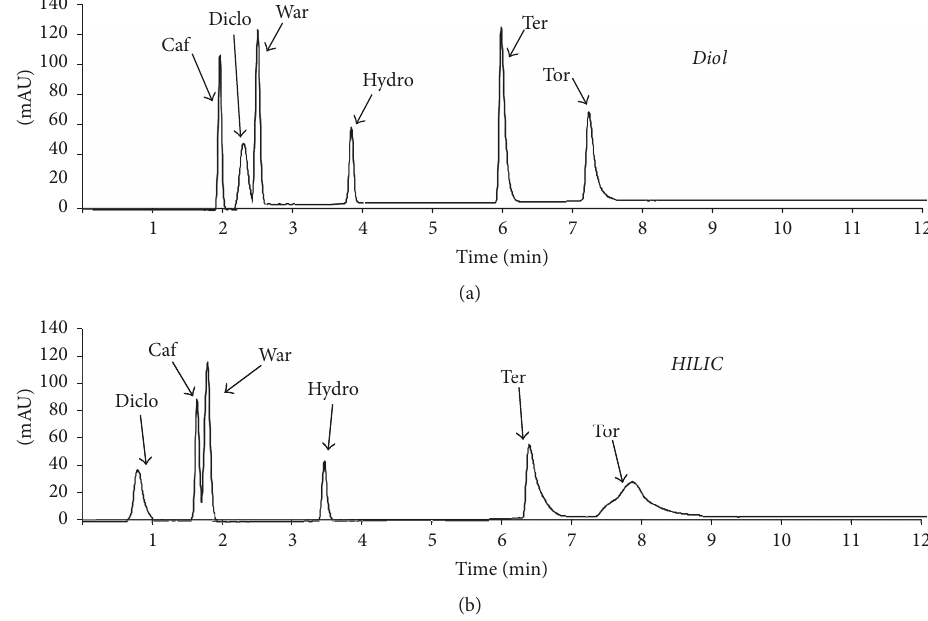
and for the design of convenient chromatographic future development and optimization